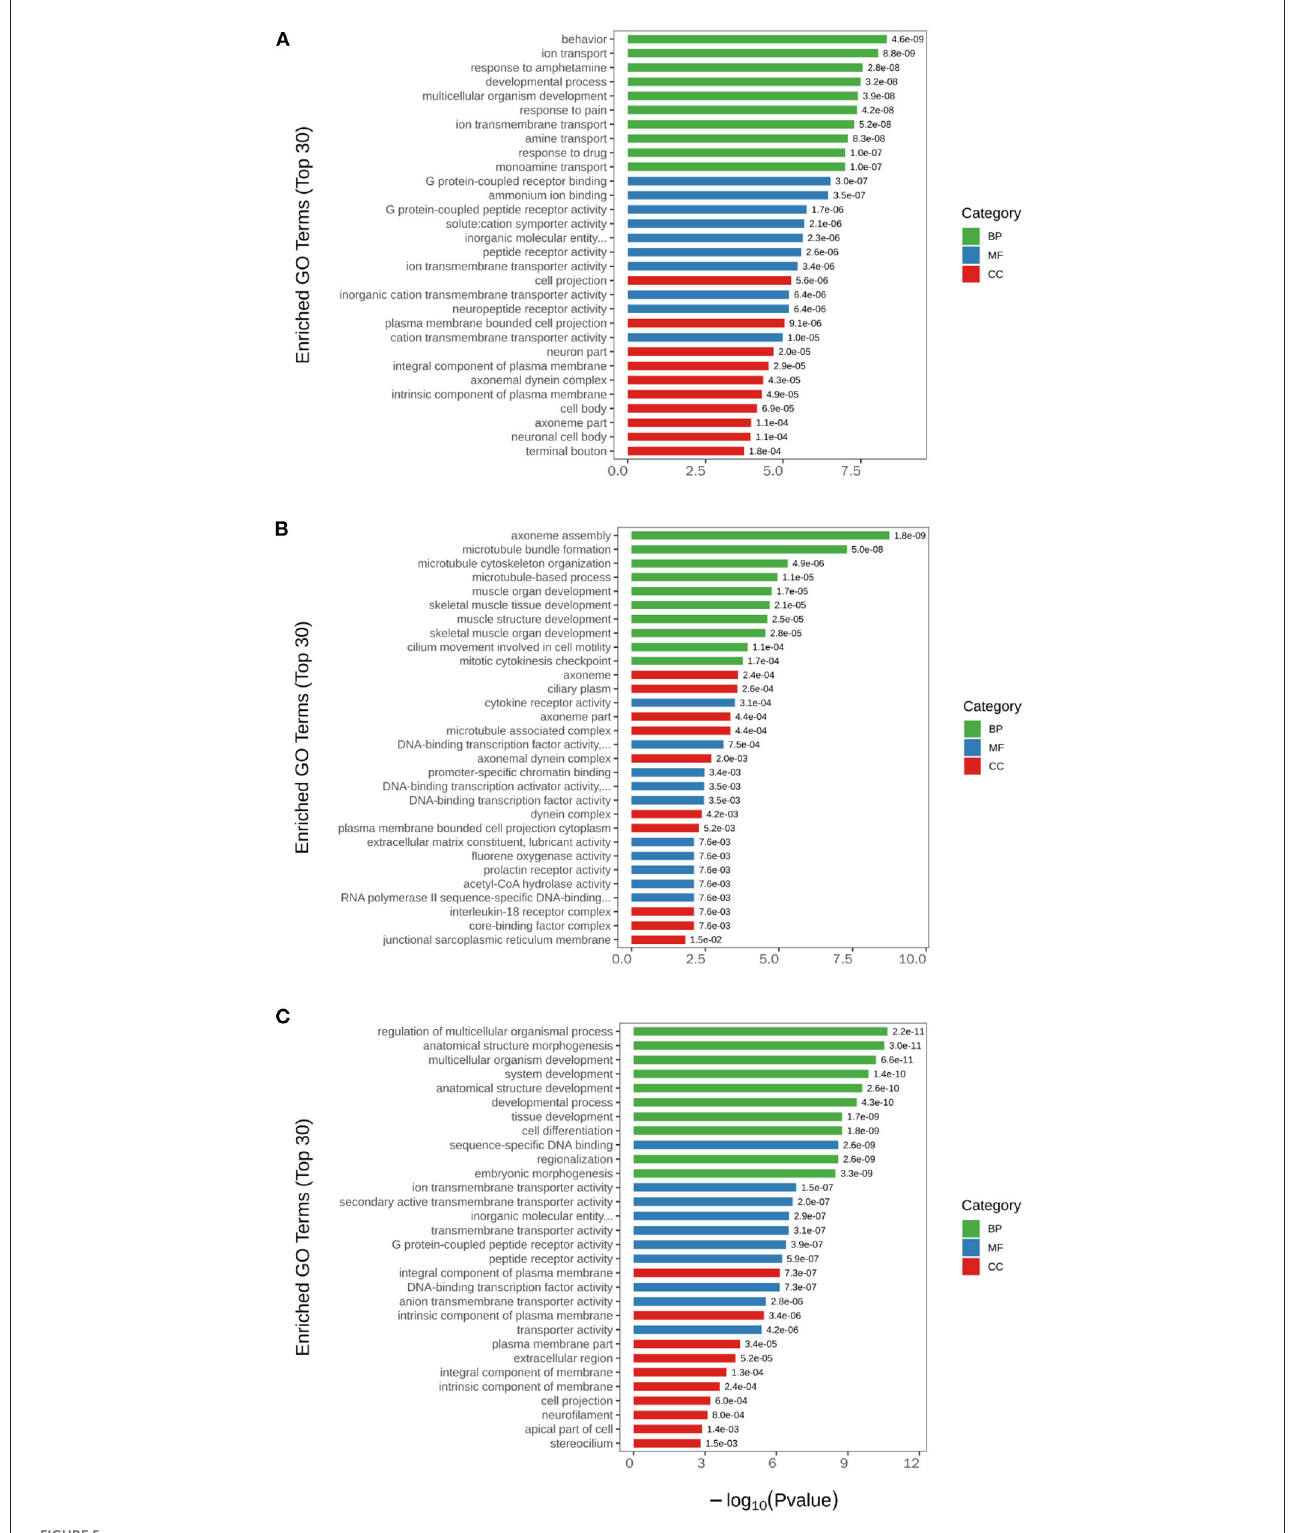
FIGURE5 GO analysis of significant DEGs. (A) H 2 group vs. control group. (B) NEMP group vs. control group. (C) NEMP + H 2 group vs. NEMP group. The vertical coordinates are top 30 enriched GO terms. The horizontal coordinate is –log10 ( P -value). The green columns represent BP terms; the blue columns represent MF terms; the red columns represent CC terms. N =